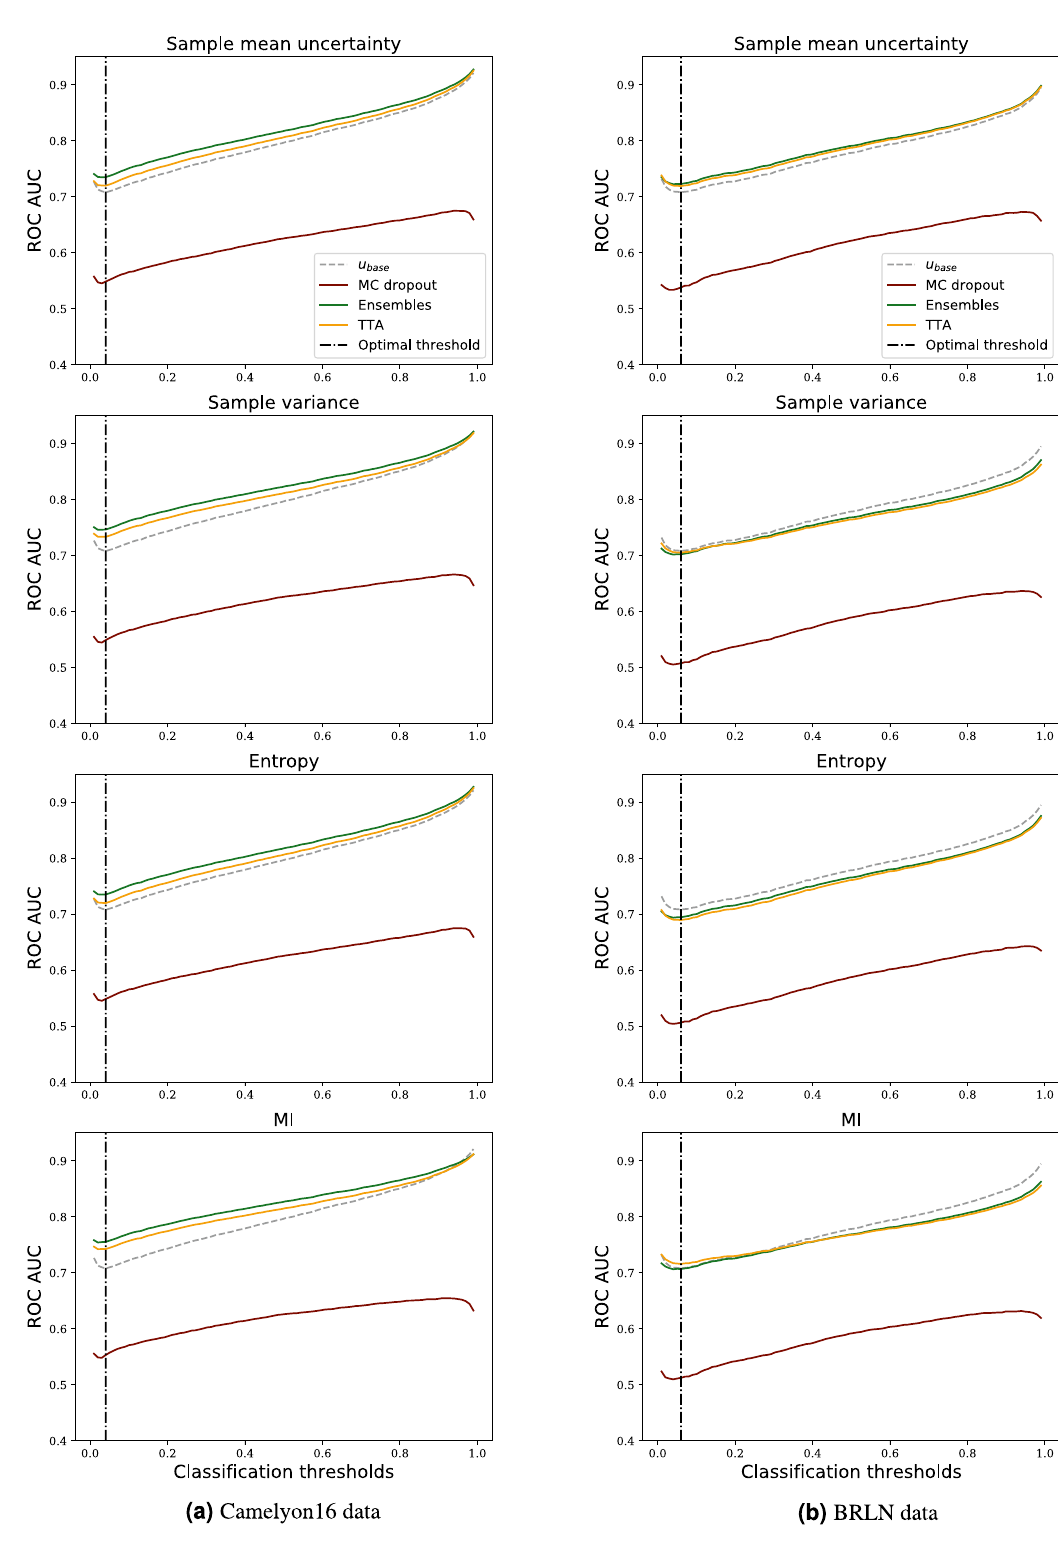
Figure 6. ROC-AUCs of misprediction detection on Camelyon16 (in-domain) and BRLN (domain shift) data sets for different thresholds used to differentiate between tumour and non-tumour predictions. The softmax- based baseline uncertainty is the same in all